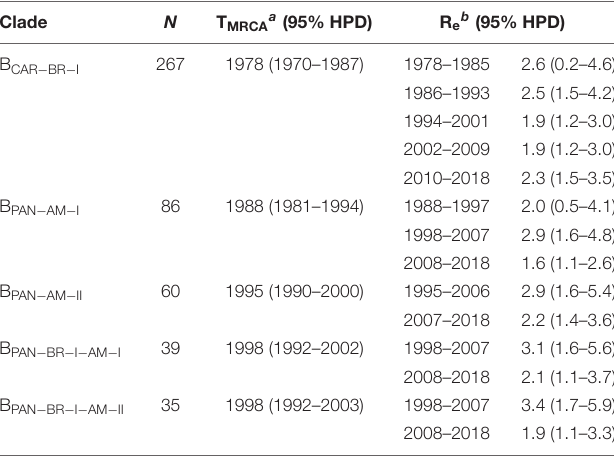
The table details the evolutionary and epidemiological parameters of the major HIV-1 subtype B clusters of pandemic (B PAN ) and non-pandemic (B CAR ) forms circulating in Brazil’s Amazonas state. a Median value and 95% HPD interval of the time to the most recent common ancestor (T MRCA ). b Median value and 95% HPD interval of the effective reproductive number (R e ) inferred in a bird-death statistical